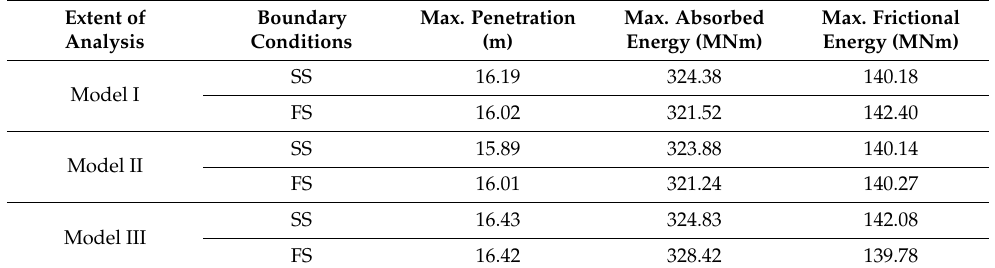
Table 3. Summary of the maximum structural response for different models and boundaries.